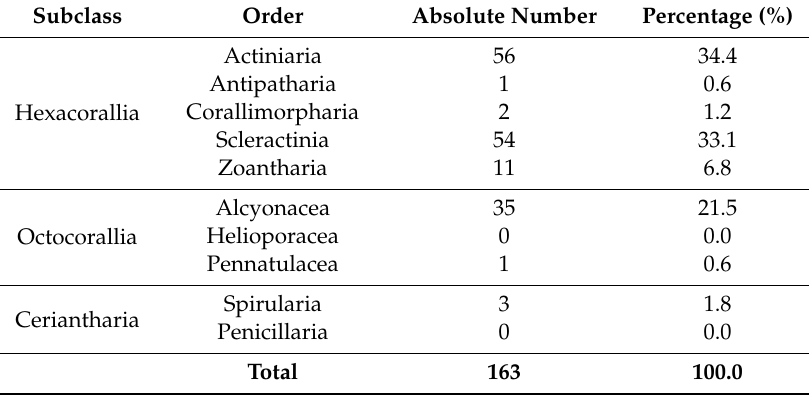
Table 2. Anthozoa orders found in selected publications considering the search “feeding”, “diet” and “food web” terms from